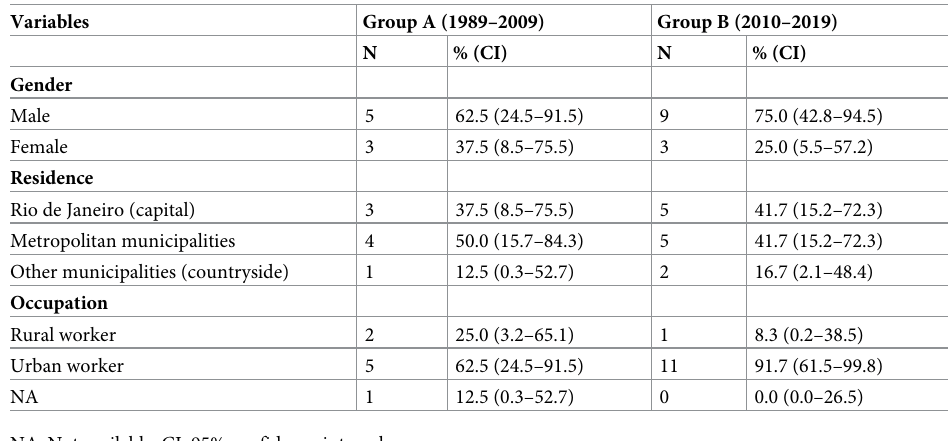
Table 1. Epidemiological characteristics of the cases analyzed in this